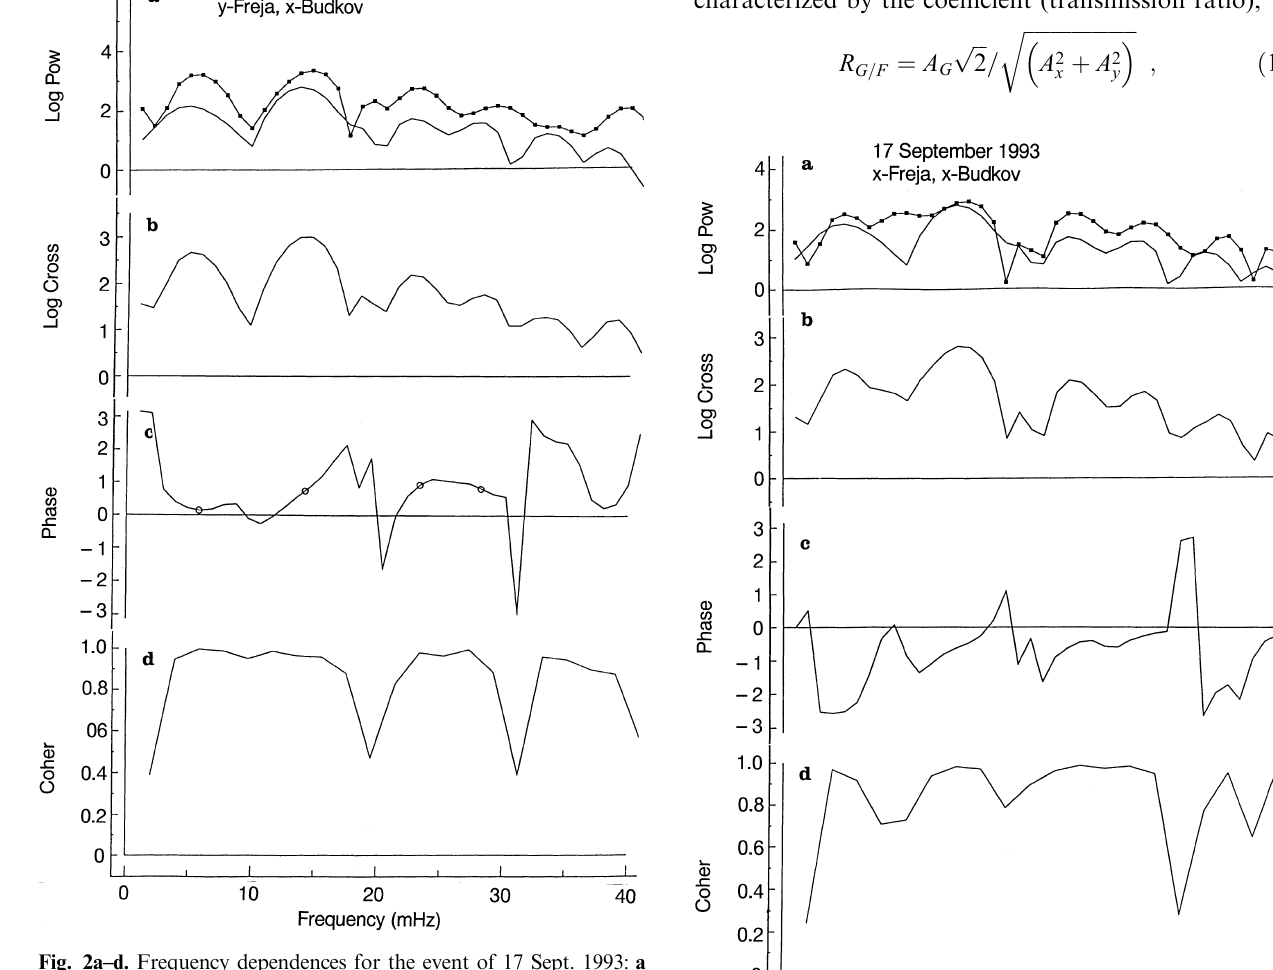
Fig. 2a–d. Frequency dependences for the event of 17 Sept. 1993: a associated power-spectra (on a logarithmic scale of nT 2 = Hz) for y - Freja ( line with squares ) and x -Budkov ( continuous line ). b The real (cid:255) (cid:1) modulus of the y -Freja and x -Budkov cross-spectrum log nT 2 = Hz . c the phase of the y -Freja and x -Budkov cross-spectrum (on rad), and d the coherence calculated for the y -Freja and x -Budkov cross- Fig. 3a–d. Frequency dependences analogous to Fig. 2, but for the x - spectrum with a smoothing frequency window 2mHz in width Freja and x -Budkov signal records of 17 Sept.